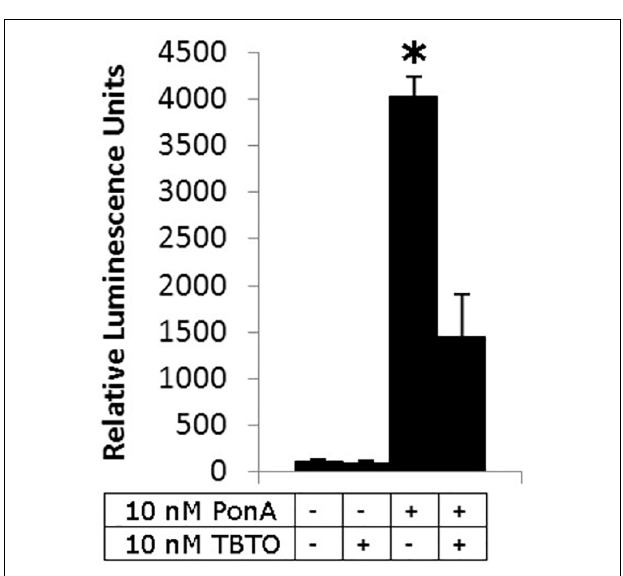
FIGURE 5 | Influence of 10 nM TBTO on reporter gene trans-activation by 10 nM PonA through CrcEcR–CrcRXR. Four different treatments were performed in quadruplicate (from left to right): a negative control, exposure to 10 nM TBTO, a positive control (10 nM PonA) and exposure to 10 nM TBTO in the presence of 10 nM PonA. Data are presented as the mean ± SEM ( n = 4). An asterisk denotes a significant difference with the respective control (Student’s t -test, two tailed, p < 0.05; Verhaegen et al., 2011; Verhaegen,